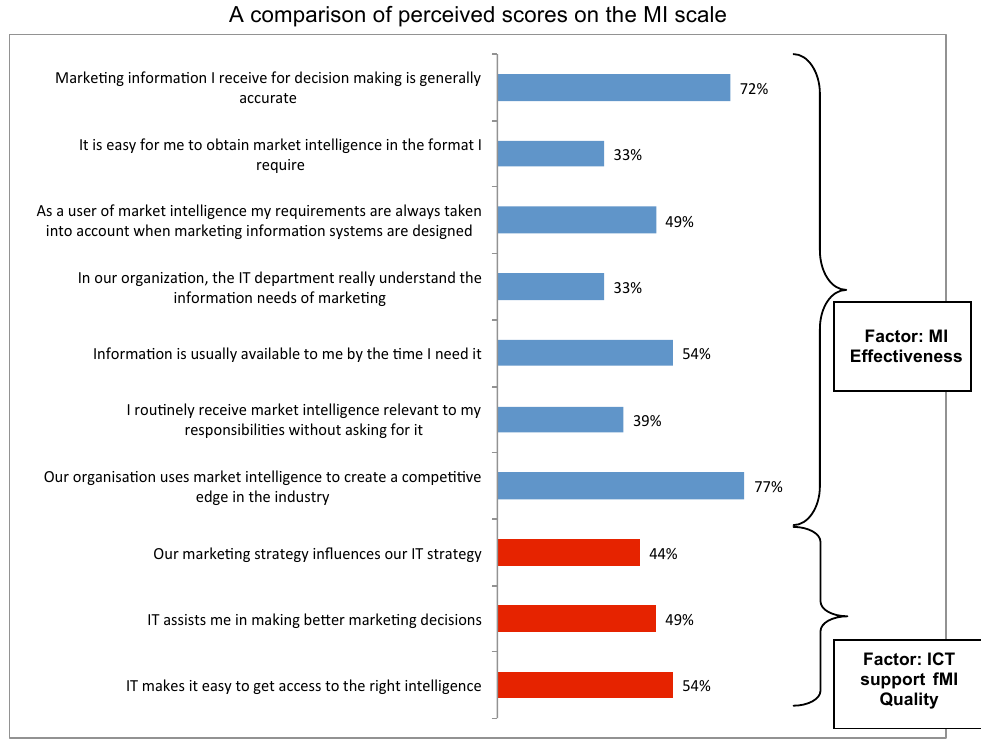
A comparison of perceived scores on the MI